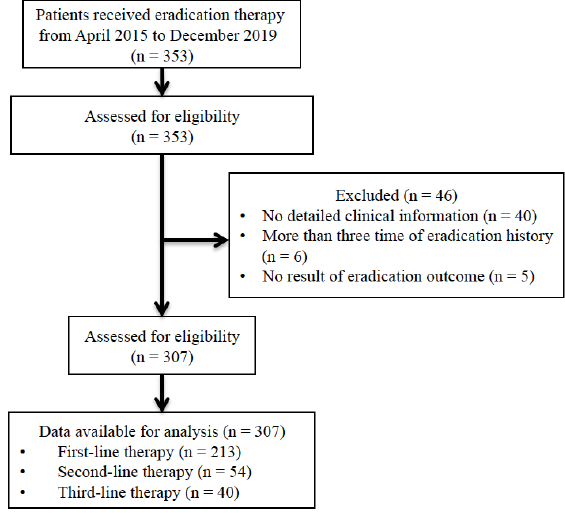
Figure 1. Flow for the selection of